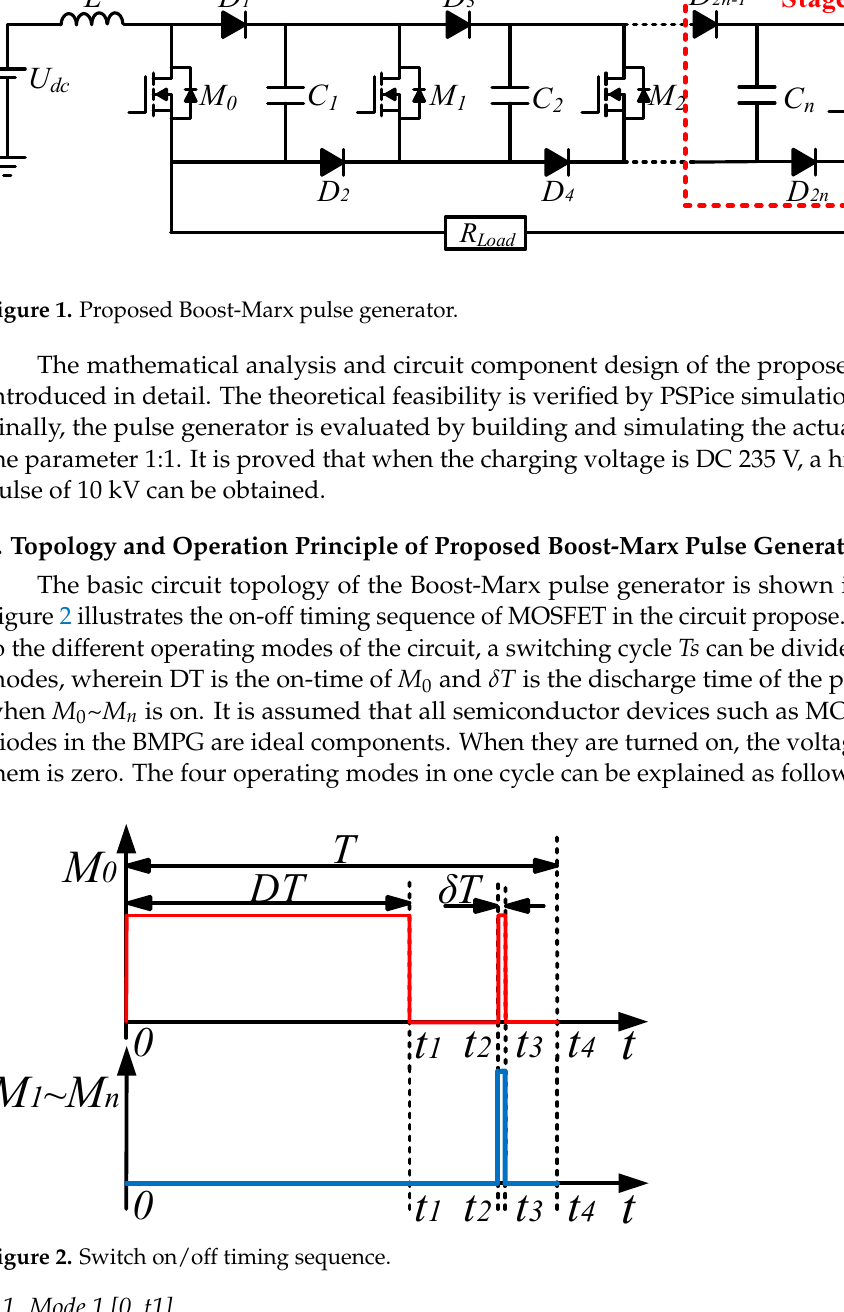
Figure 1. Proposed Boost-Marx pulse generator.